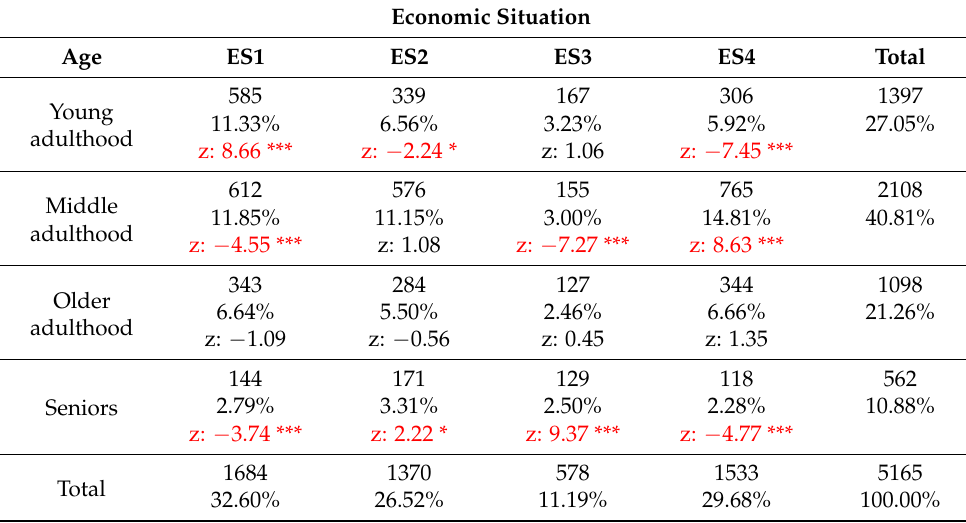
Table 2. Economic situation’s dependence on